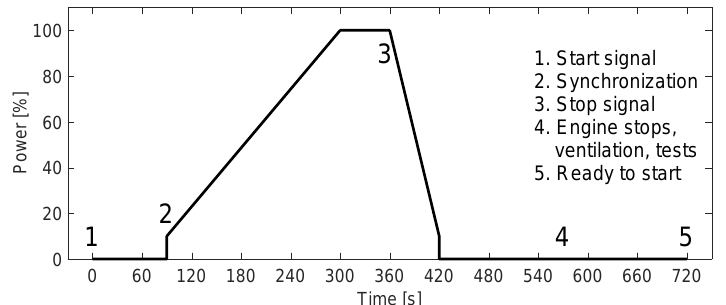
Figure 1. Performance of a gas engine in start-up and shut-down [17]. The engine has no minimum on-time once it has